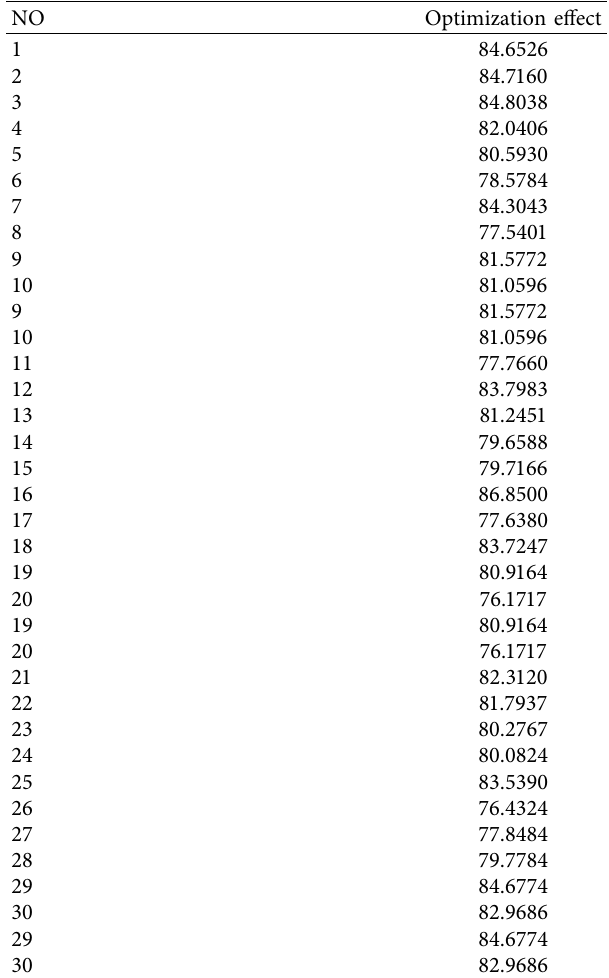
Table 1: Verification of the reactive power optimization effect of the distribution network based on multiagent and multiagent deep reinforcement